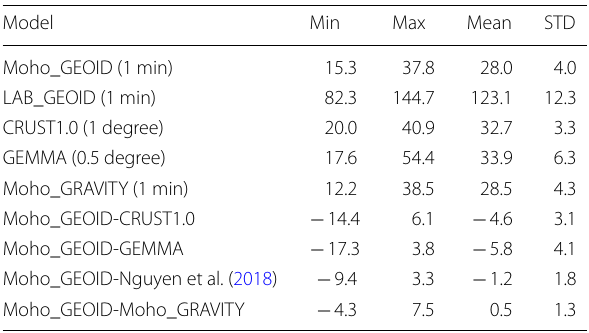
Table 4 Statistics of Moho and LAB depth models over Vietnam